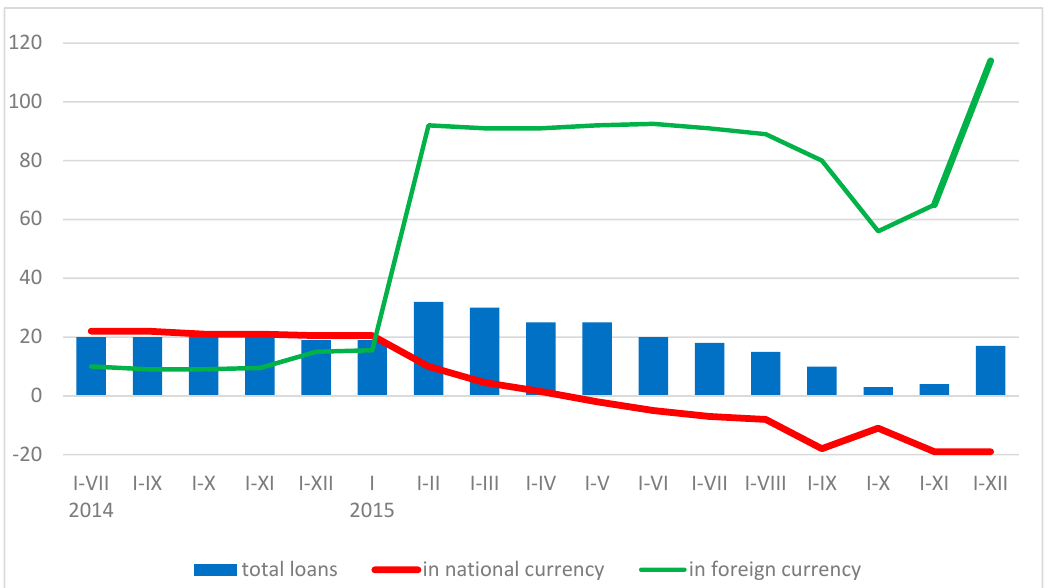
Figure 1. Growth rates of loans, %. Source: Reproduced from CBAR SB (2015).